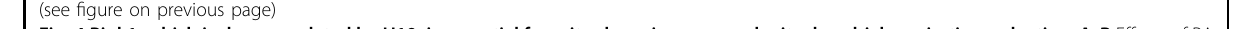
Fig. 4 Pink1, which is downregulated by H19, is essential for mitophagy increase and mitochondrial respiration reduction. A , B Effects of PA and mitophagy inducers (CCCP) on Fundc1 ( A ), Binp3/Nix ( A ) and Pink1 expressions ( B ) in whole cell lysates ( n = 3). Results of optical density analyses were presented in Sup. Fig. 2B, C. C Effects of PA on contents of Pink1/Parkin and ubiquitination levels in mitochondrial proteins of H9c2 cells ( n = 3). Results of optical density analyses were presented in Sup. Fig. 2D. D Pink1/Parkin contents in WT or Lep − / − mice ( n = 6). Results of optical density analyses were presented in Sup. Fig. 2E. E Representative images of JC-1 probe detected by fl ow cytometry in H9c2 cells with different treatments. Green signal indicates mitochondrial membrane potential depolarization. Statistical analyses were performed base on three biological replicates. F , G Effects of PA and siRNA against Pink1 on the levels of phospho-ubiquitin in the whole cell and isolated mitochondrial proteins in H9c2 cells ( n = 3). Results of optical density analyses were presented in Sup. Fig. 2G, H. H Levels of phospho-ubiquitin in whole cell lysates from left ventricular of WT or Lep − / − mice ( n = 6). Results of optical density analyses were presented in Sup. Fig. 2I. I – K Contents of Pink1 or Parkin proteins in whole cell lysates or isolated mitochondria from H9c2 cells with different treatment ( I ), ( J ) and different mice ( K ) ( n = 3). Results of optical density analyses were presented in Sup. Fig. 2K – M. L Seahorse exhibited the alteratons of respiratory capacity following treatments with PA and siRNA against Pink1. Data in E and L are expressed as mean ± SEM. * P < 0.05; ** P < 0.01; *** P < 0.001. BSA, bovine serum albumin; PA, palmitic acid; CCCP, mitophagy inducer; TOM20, translocase of the outer membrane 20, mark of mitochondria; Lep − / − , B6-OB mice with leptin defects; WT, littermate control of Lep − / − ; si-Pink1, small interference RNA against Pink1; si-NE-Con, negative control of si-Pink1; H19, H19 overexpression; Vector, control lentivirus of H19; OCR, oxygen consumption rate.